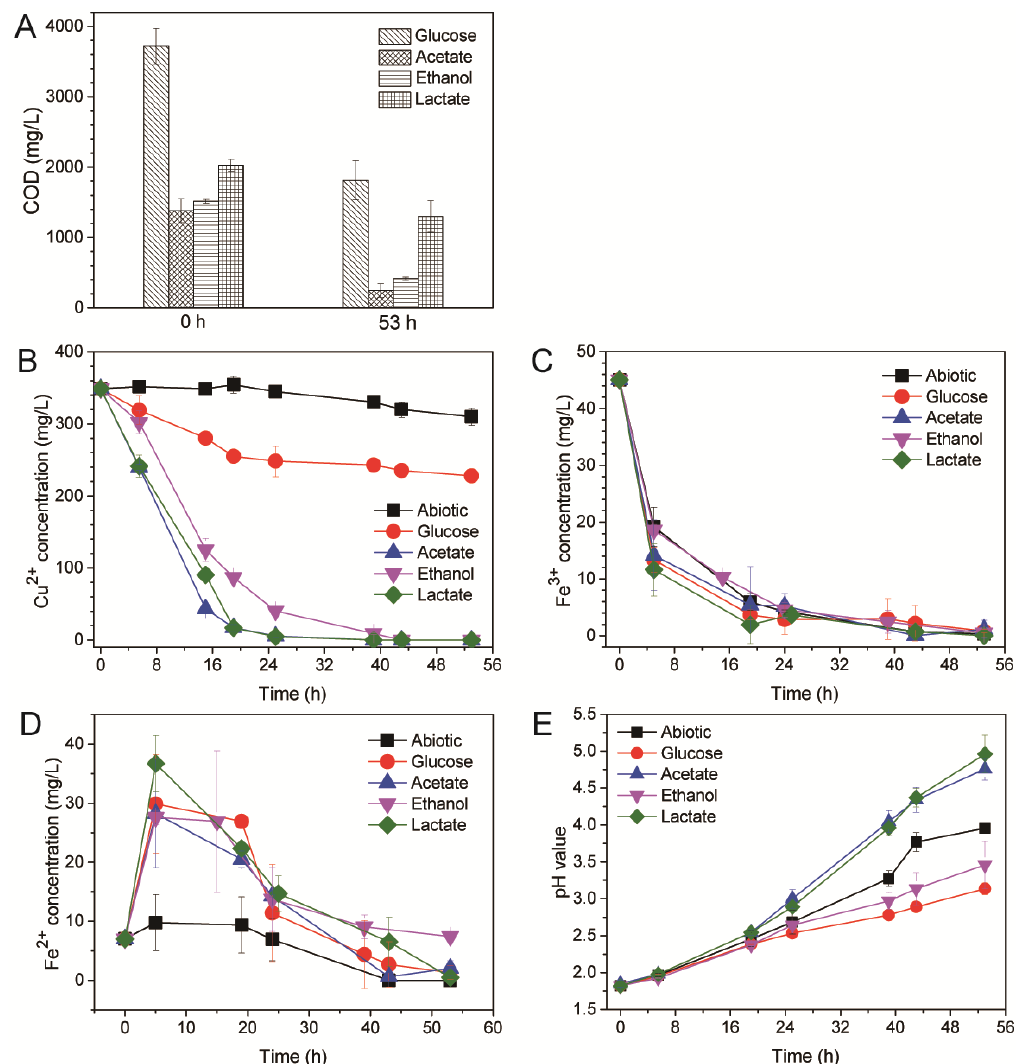
Figure 7. The changes in chemical oxygen demand (COD) in anode chamber ( A ), and cupric ion ( B ), ferric iron ( C ), ferrous iron ( D ), and pH value ( E ) of cathode chamber of the MFCs containing electroactive biofilms enriched with different energy substrates.